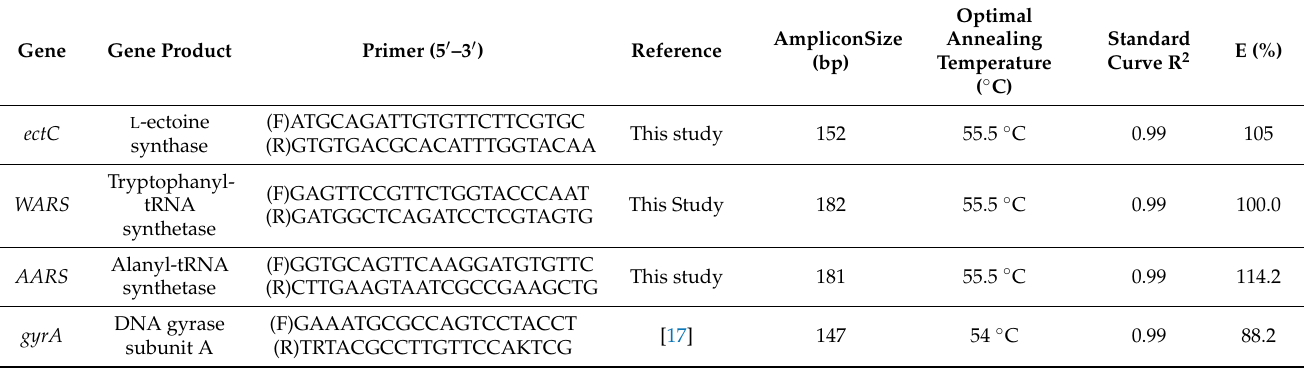
Table 1. Selected candidate reference genes, corresponding product name, primer sequences, ampli- con size (bp), PCR amplification efficiencies and the mean C T values ( ± standard deviation) assessed in A. aelioanus cells under high and low salt. R 2 : correlation coefficient of the standard curve; E: PCR efficiency